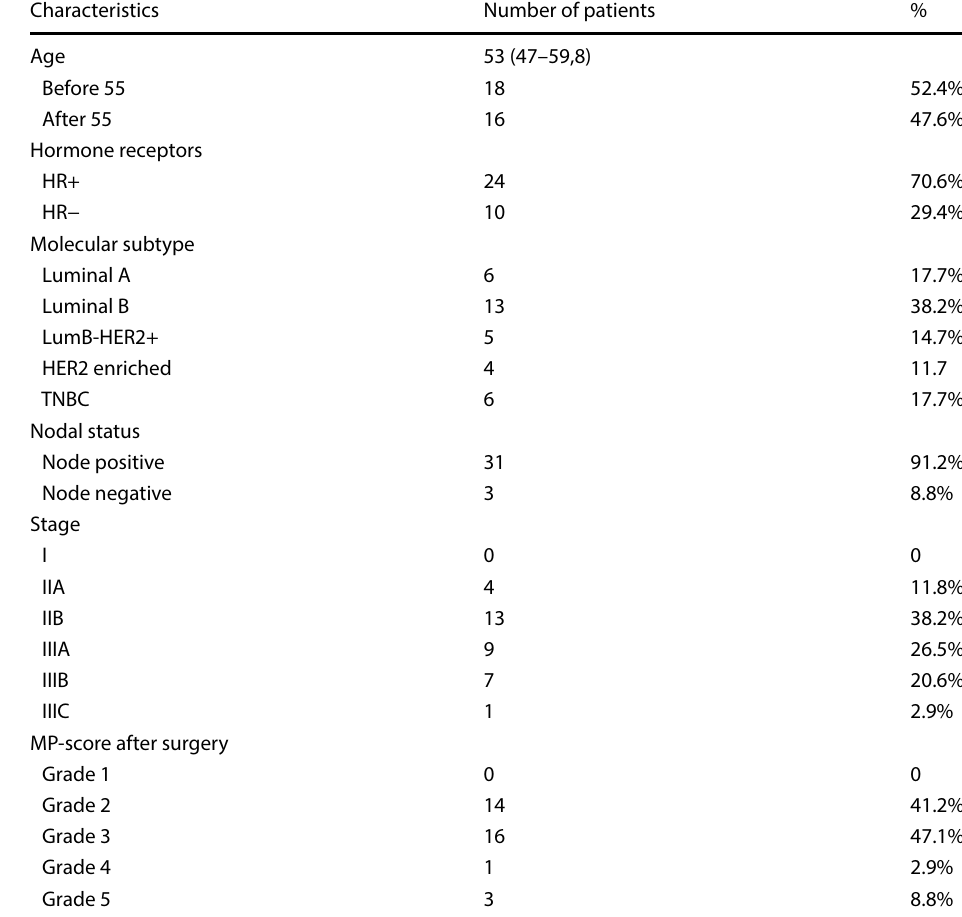
Table 1 Clinical-pathological characteristics of patients